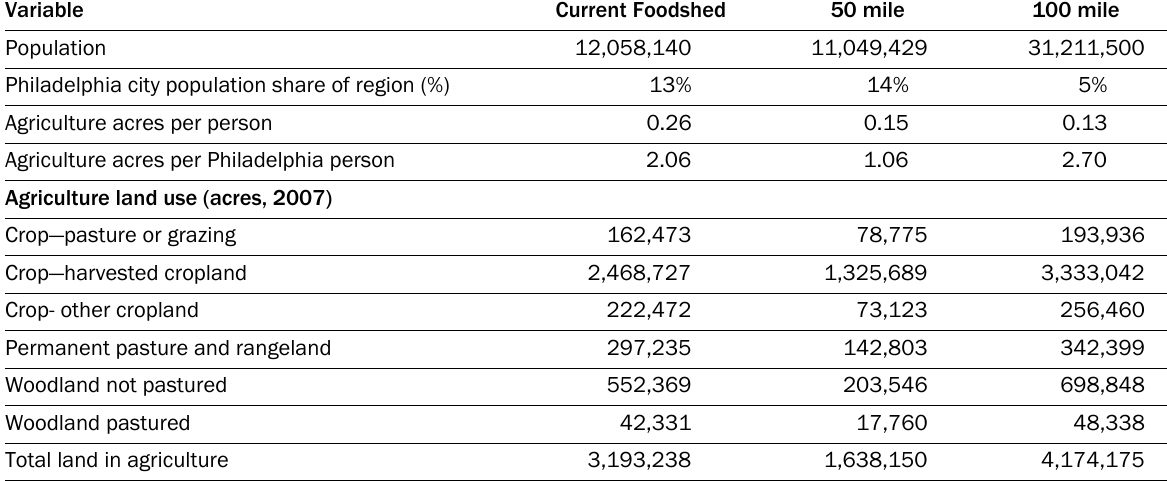
Table 1. Summary of Land Use and Agricultural Production in Three Foodshed Regions